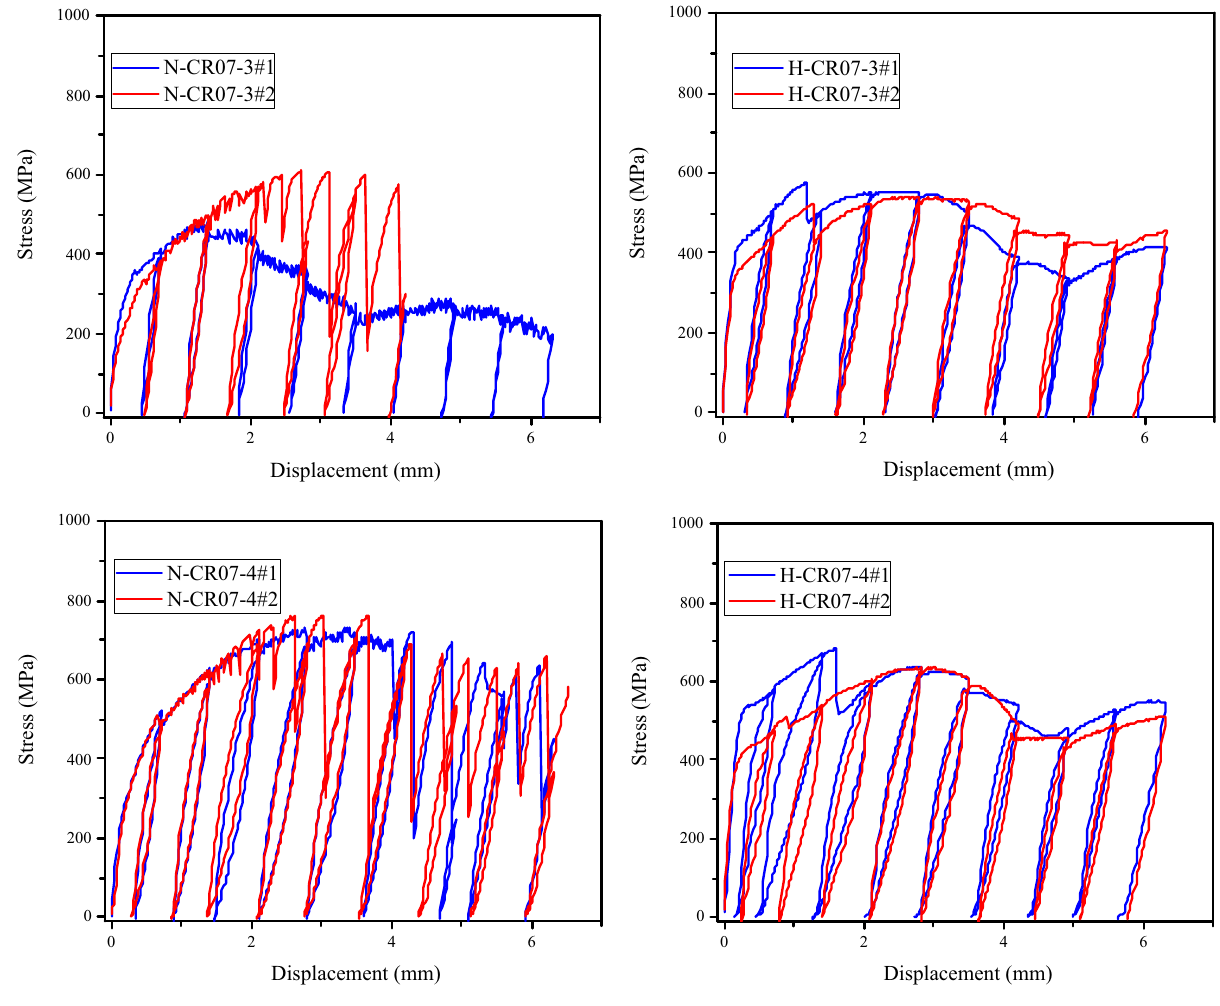
Figure 4: Pullout response of crimped fi ber with 0.7 mm